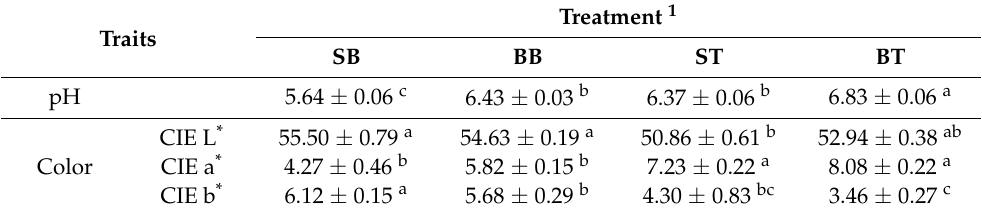
Table 1. Breast and thigh muscle pH and color in spent hens and broilers.